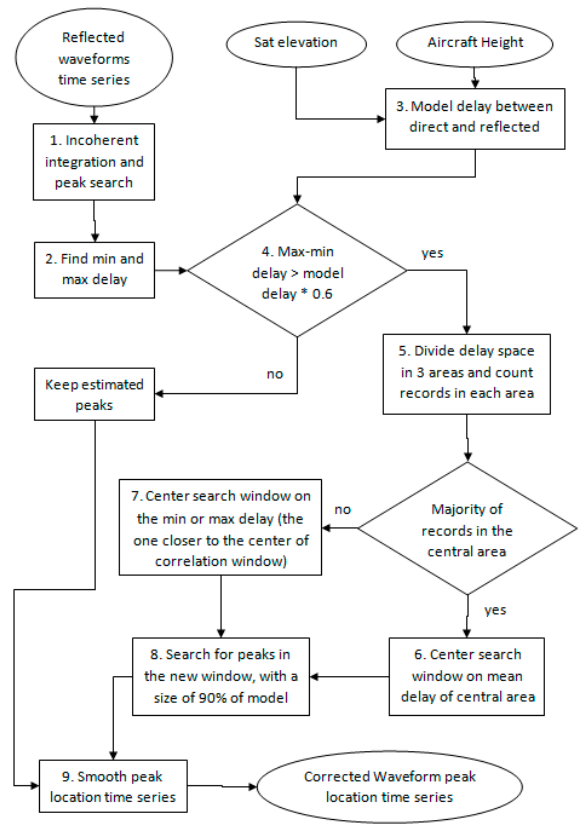
Figure 9. Flowchart of the multipath mitigation algorithm used for the GLORI data.